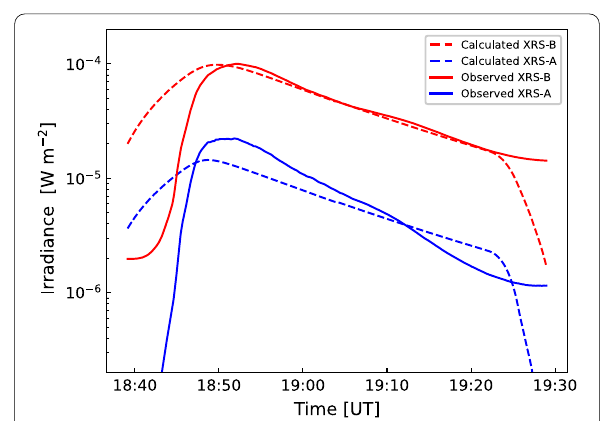
Fig. 7 Observed and reproduced light curves of GOES/XRS-A and GOES/XRS-B. The dashed and solid lines indicate the reproduced and observed light curves of GOES/XRS during the M9.9-class flare on January 1, 2014, respectively. The red and blue lines represent GOES/ XRS-B and GOES/XRS-A,